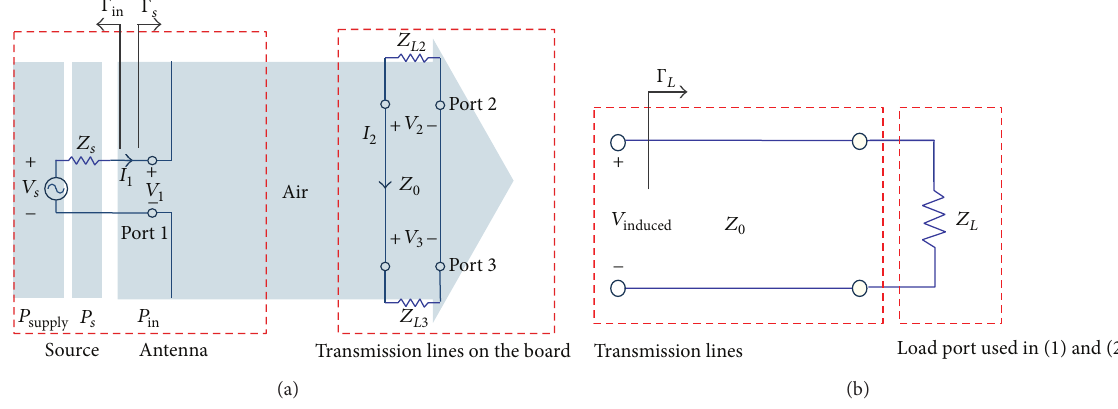
Figure 5: (a) Diagram for an antenna and transmission lines on the board. (b) Simplified equivalent transmission line model of the right side of (a). Note that 𝑍 𝐿 is an equivalent impedance for the sum of 𝑍 𝐿2 and 𝑍 𝐿3 .